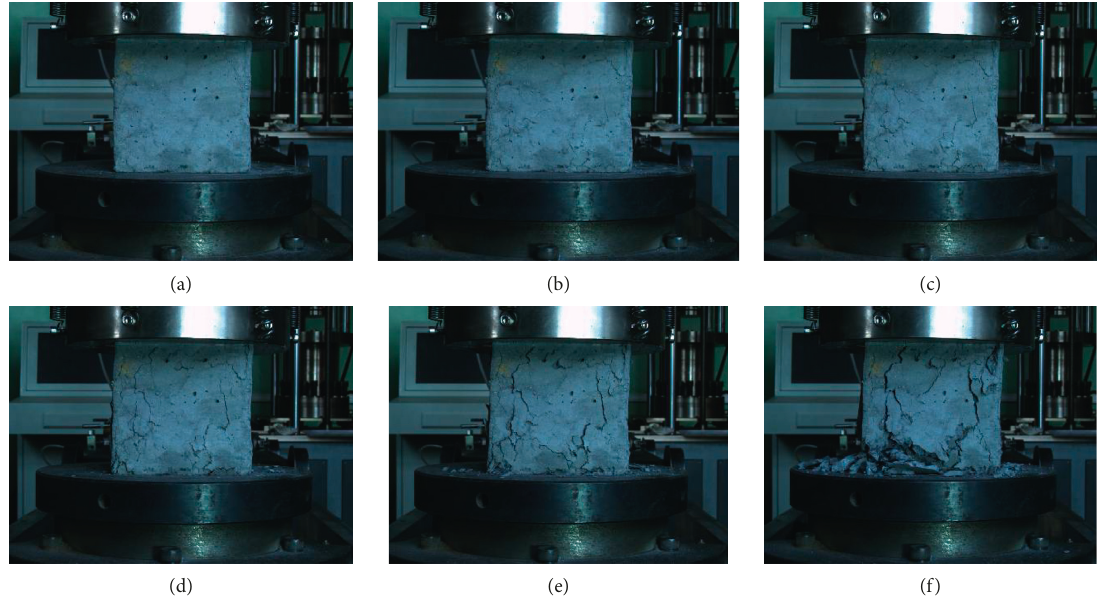
Figure 9: Characteristics of the external failure with 50% waste concrete substitution under uniaxial loading. (a–f) correspond to 0- σ σ b - σ c , σ b - σ c , σ c - σ d , and σ c - σ d of the stress stage in Figure